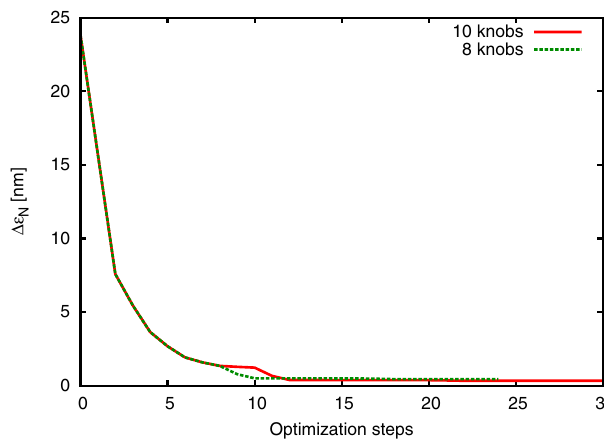
FIG. 16. Accelerating structure displacements of the 100 first structures (positioned next to the 100 first focusing quadrupoles) for the two most efficient knobs. The displacements are seen to vary approximately with the betatron frequency of the CLIC main linac.